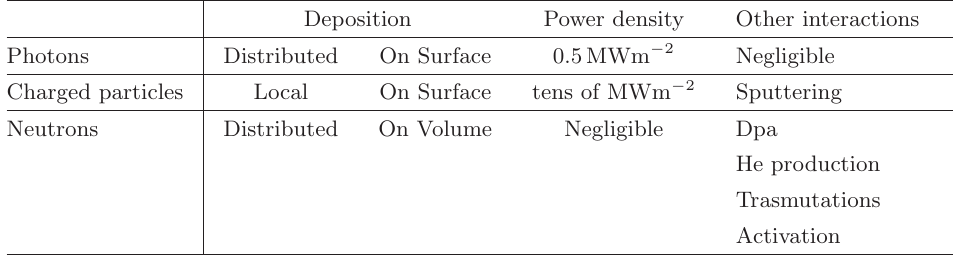
Table I. – Differences between the different nature of loading inside a fusion